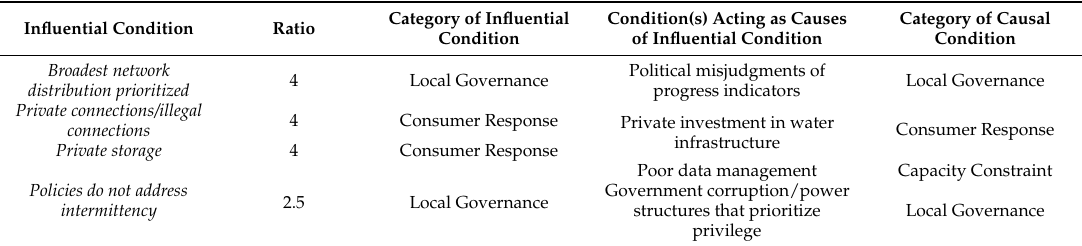
Table 4. Influential Conditions and their Causes.